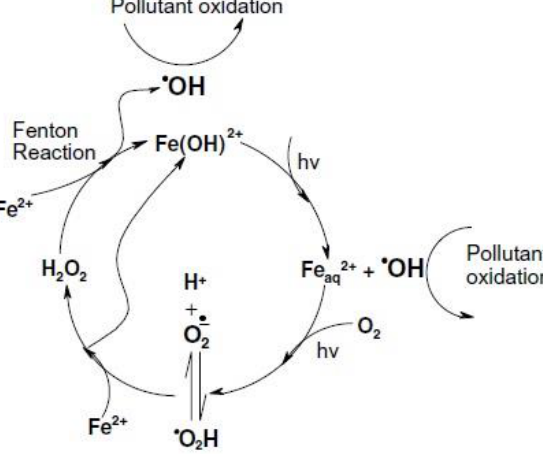
Figure 4. Model of photo-Fenton mechanism using iron-based catalysts. Reproduced with permission from Reference [104].